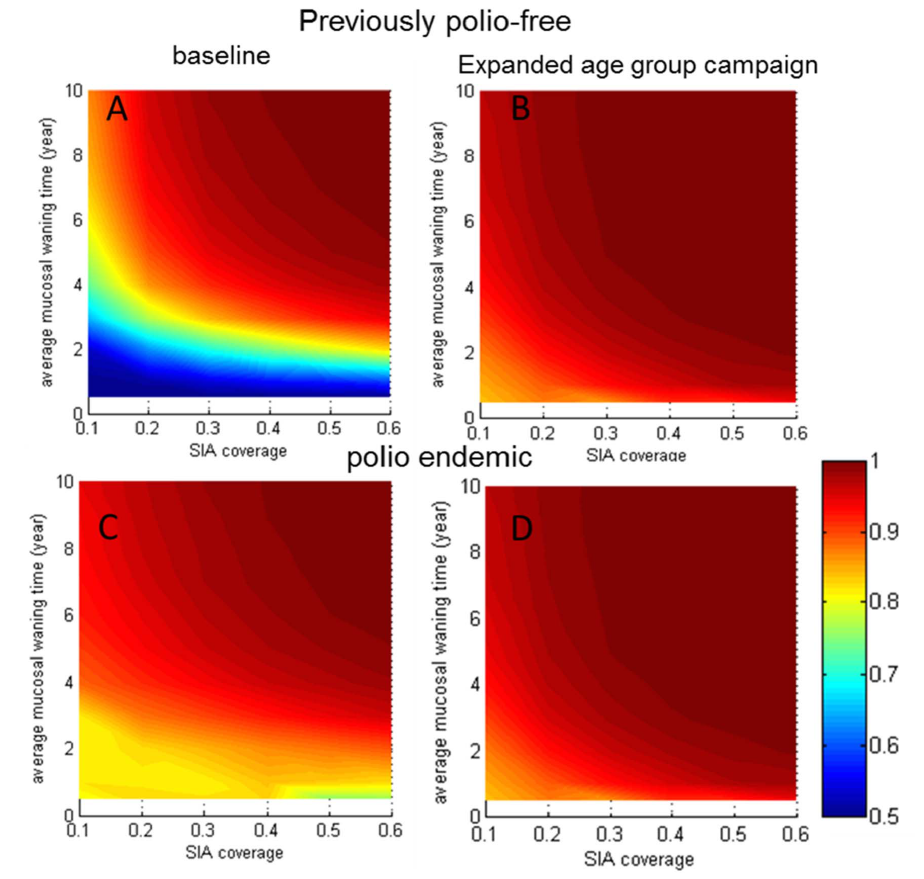
Figure 6. The distribution of mucosal immunity in 5–14 year-olds in EAG campaigns compared with standard campaigns targeting 0–4 year-olds. Average mucosal immunity waning time was varied between 6 months and 10 years (half-life 0.34–7 years), and SIA coverage between 10%–60% per round. We reported the results in fractions of mucosal antibody titer . 8, assuming a fixed fraction of acquired viral dose, P A ~ 10 { 7 . We note that other values of P A yield similar results: ( A ) no wild poliovirus circulation, baseline; ( B ) no wild poliovirus circulation, expanded age group campaigns; ( C ) with wild poliovirus circulation ( p 0 , inf , s ~ 1 : 7 ), baseline scenario; and ( D ) with wild poliovirus circulation ( p 0 , inf , s ~ 1 : 7 ), expanded age group